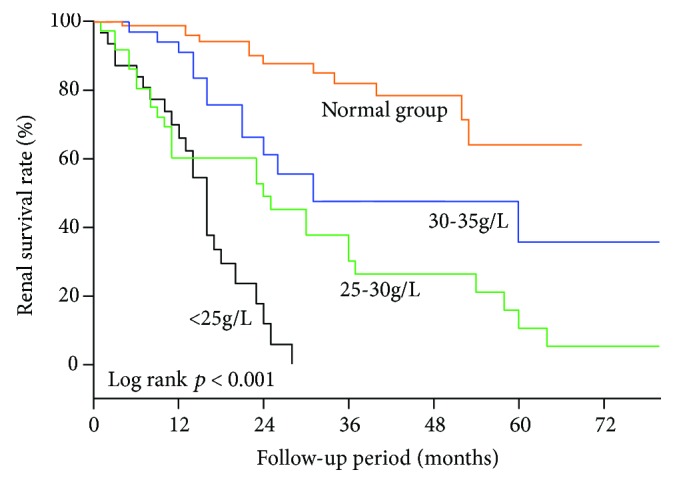
Kaplan–Meier curves of the renal survival rate in DN patients with different serum albumin levels. The 5-year renal survival rate was estimated to be 64.14%, 35.70%, 10.54%, and 0% for the normal (≥35 g/L), mild (30-35 g/L), moderate (25-30 g/L), and severe (<25 g/L) groups, respectively. Median survival time for ESRD after renal biopsy was 31 months, 24 months, and 16 months for the mild, moderate, and severe groups, respectively. There was a significant difference of the renal survival rate between any two groups (p < 0.05).